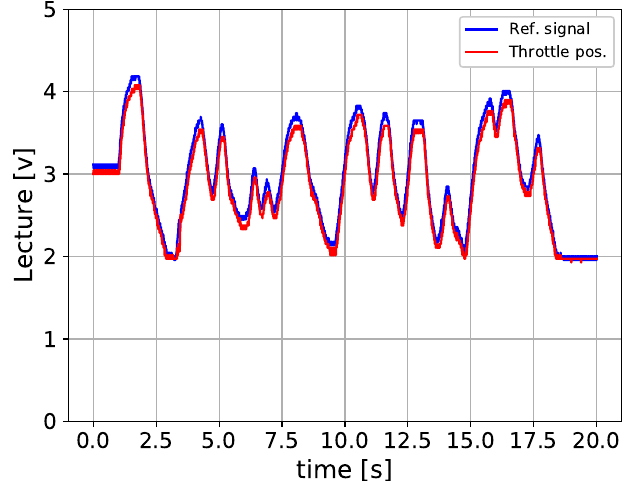
The throttle valve position following the reference signal induced by the pedal emulator